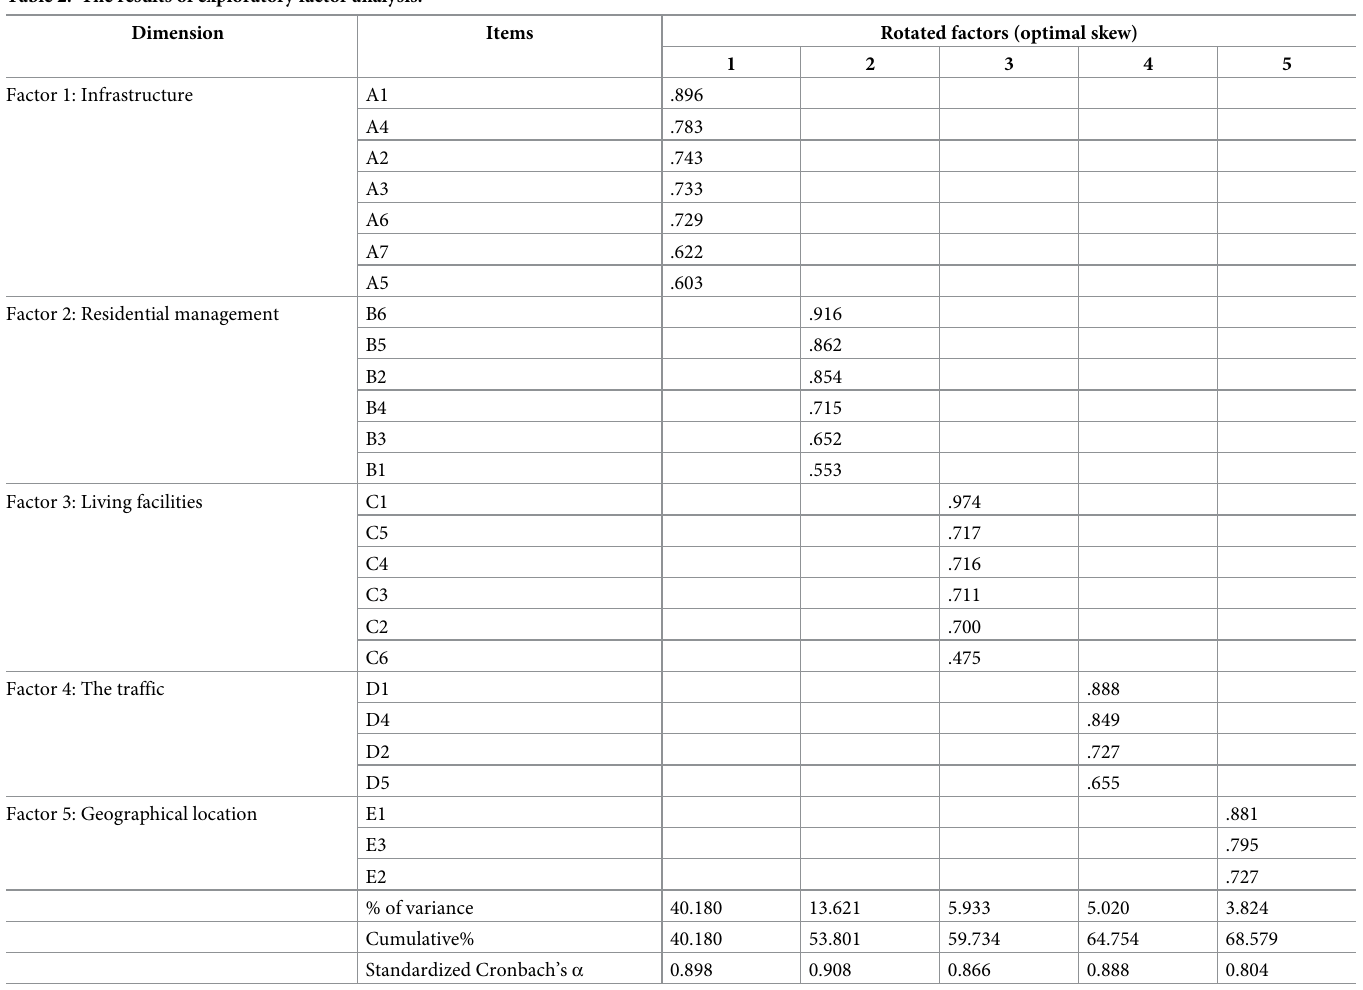
Table 2. The results of exploratory factor analysis.